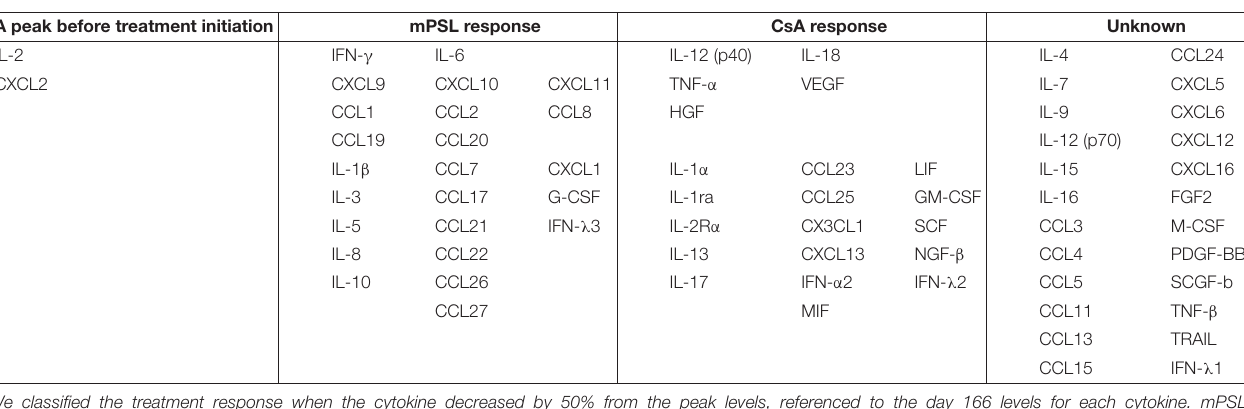
TABLE 2 | Summary of cytokines which respond to each treatment ( n = 71).